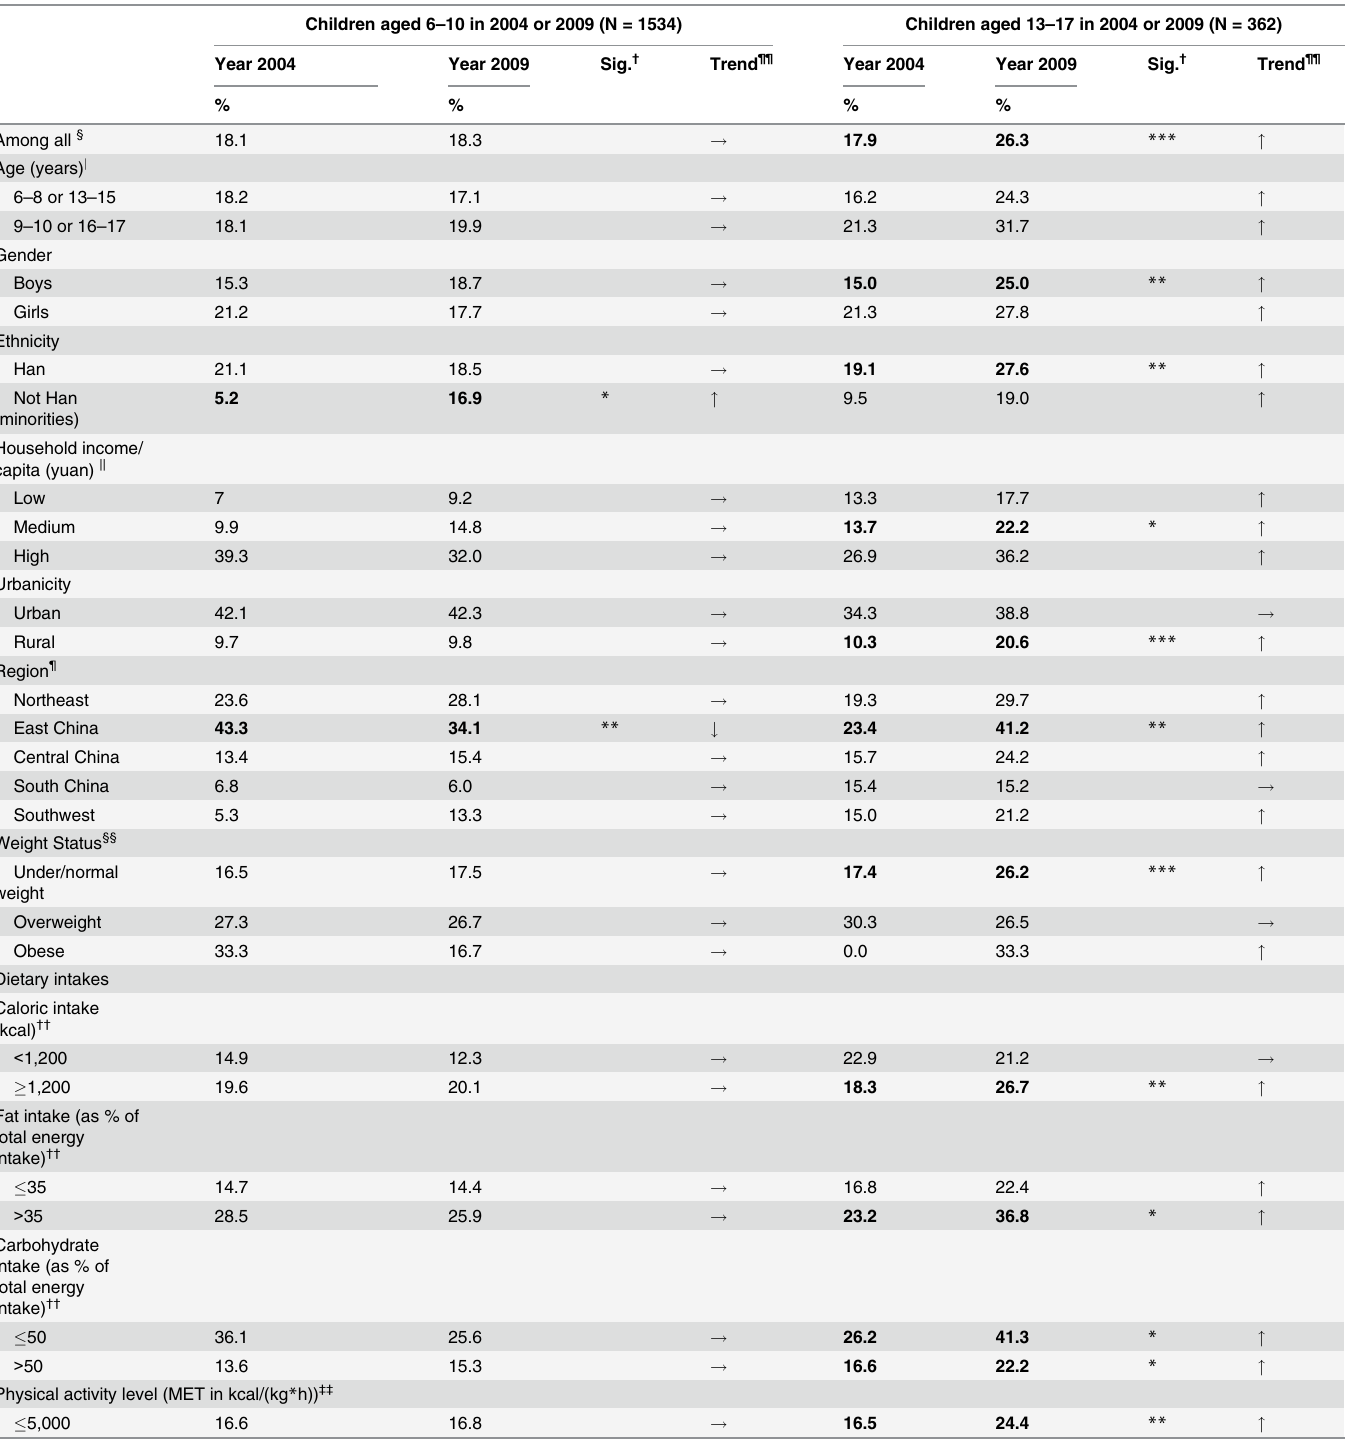
Table 3. Time trends in the percentage (%) of Western fast food consumers among Chinese children of the same age between 2004 and 2009, by age group (those aged 6 – 10 vs 13 – 17 years old), socio-demographics, lifestyles and weight status: China Health and Nutrition